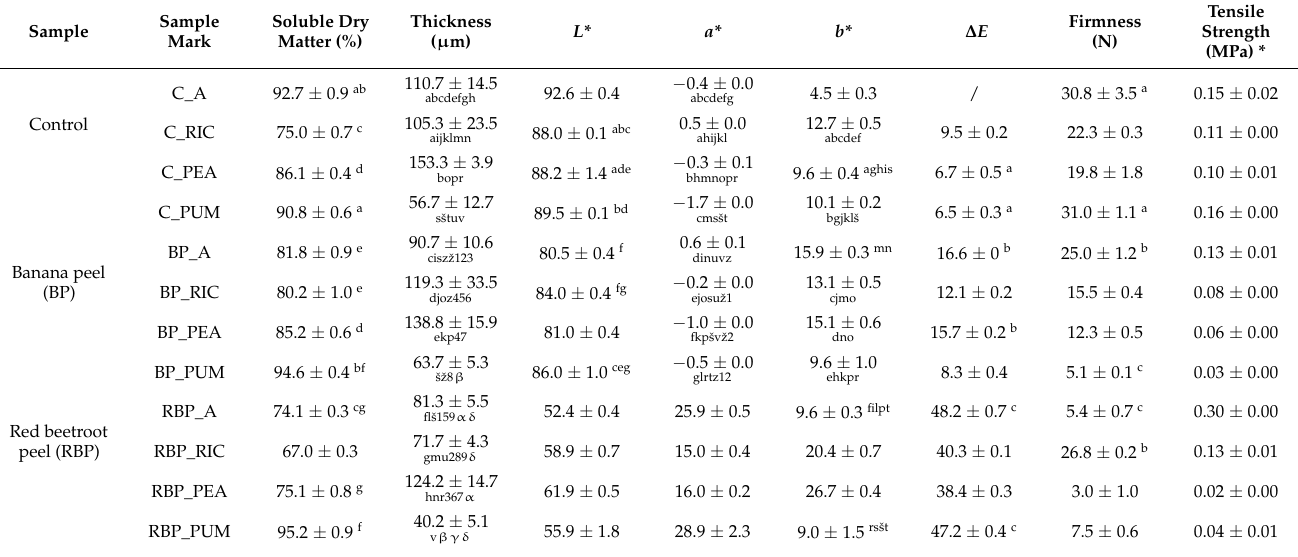
Table 3. Physical and mechanical parameters of formulated edible